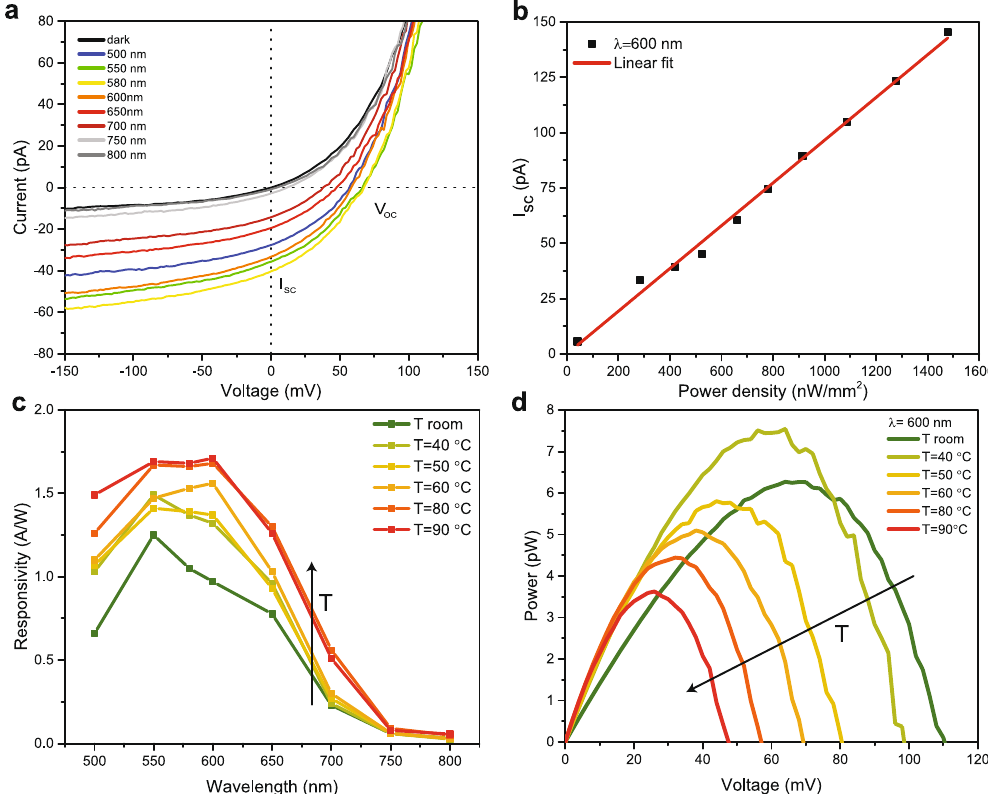
Figure 4. Photoresponse of MoS 2 /VO 2 heterojunction. ( a ) I–V characteristic of D1 in linear scale under different illumination wavelengths, from 500 nm to 800 nm. The measurements have been performed under an incident power density close to 330 nW/mm 2 for all the wavelengths and at room temperature. ( b ) Short circuit current of the heterostructure as a function of the incident power density, showing a linear dependency. ( c ) Spectral evolution of the photoresponsivity measured at different temperatures. At room temperature, a responsivity larger than the one of conventional silicon p-n photodiode is measured in the spectral range 500/650 nm. The responsivity in the visible spectrum is boosted by the increase of temperature and it saturates for temperatures above the IMT of VO 2 . ( d ) Electrical power generated by the photodiode under 600 nm illumination with an incident power density of 1.48 μ W/mm 2 . The electrical power that the heterojunction can effectively harvest decreases with the increase of the